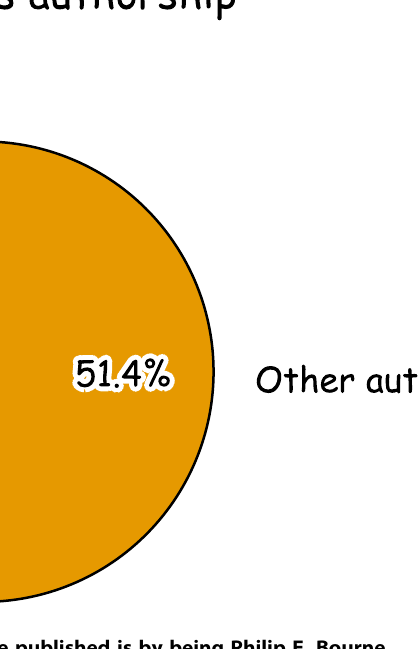
PLOS Computational Biology |